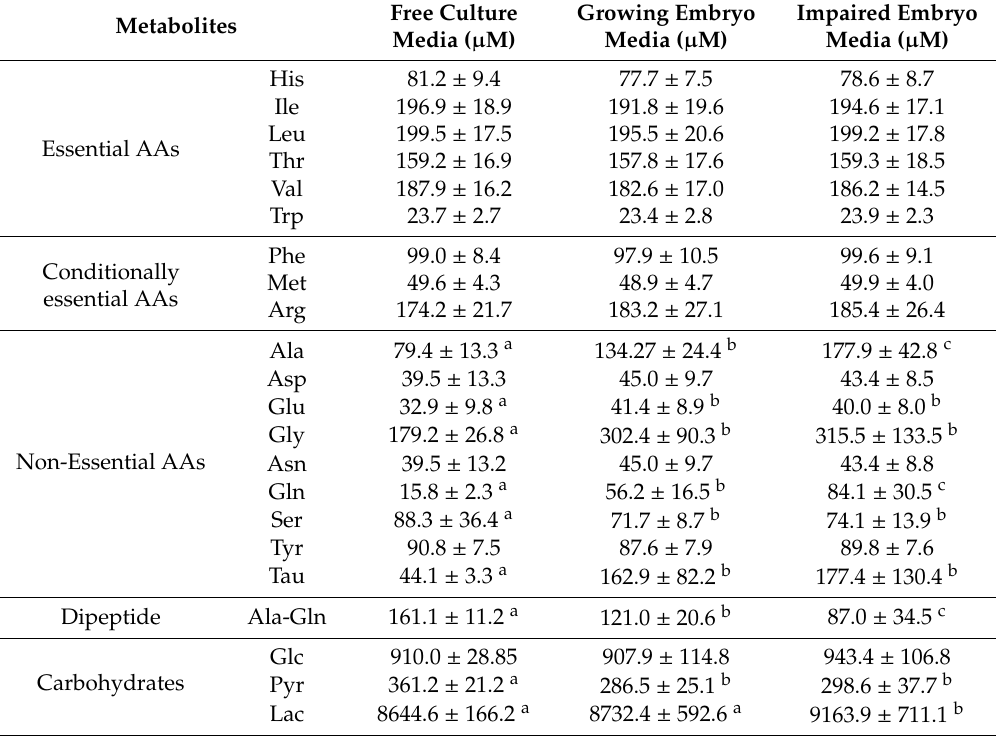
Table 1. Mean concentration of metabolites ( µ M) in the free culture media and the media containing the growing and impaired single embryos to